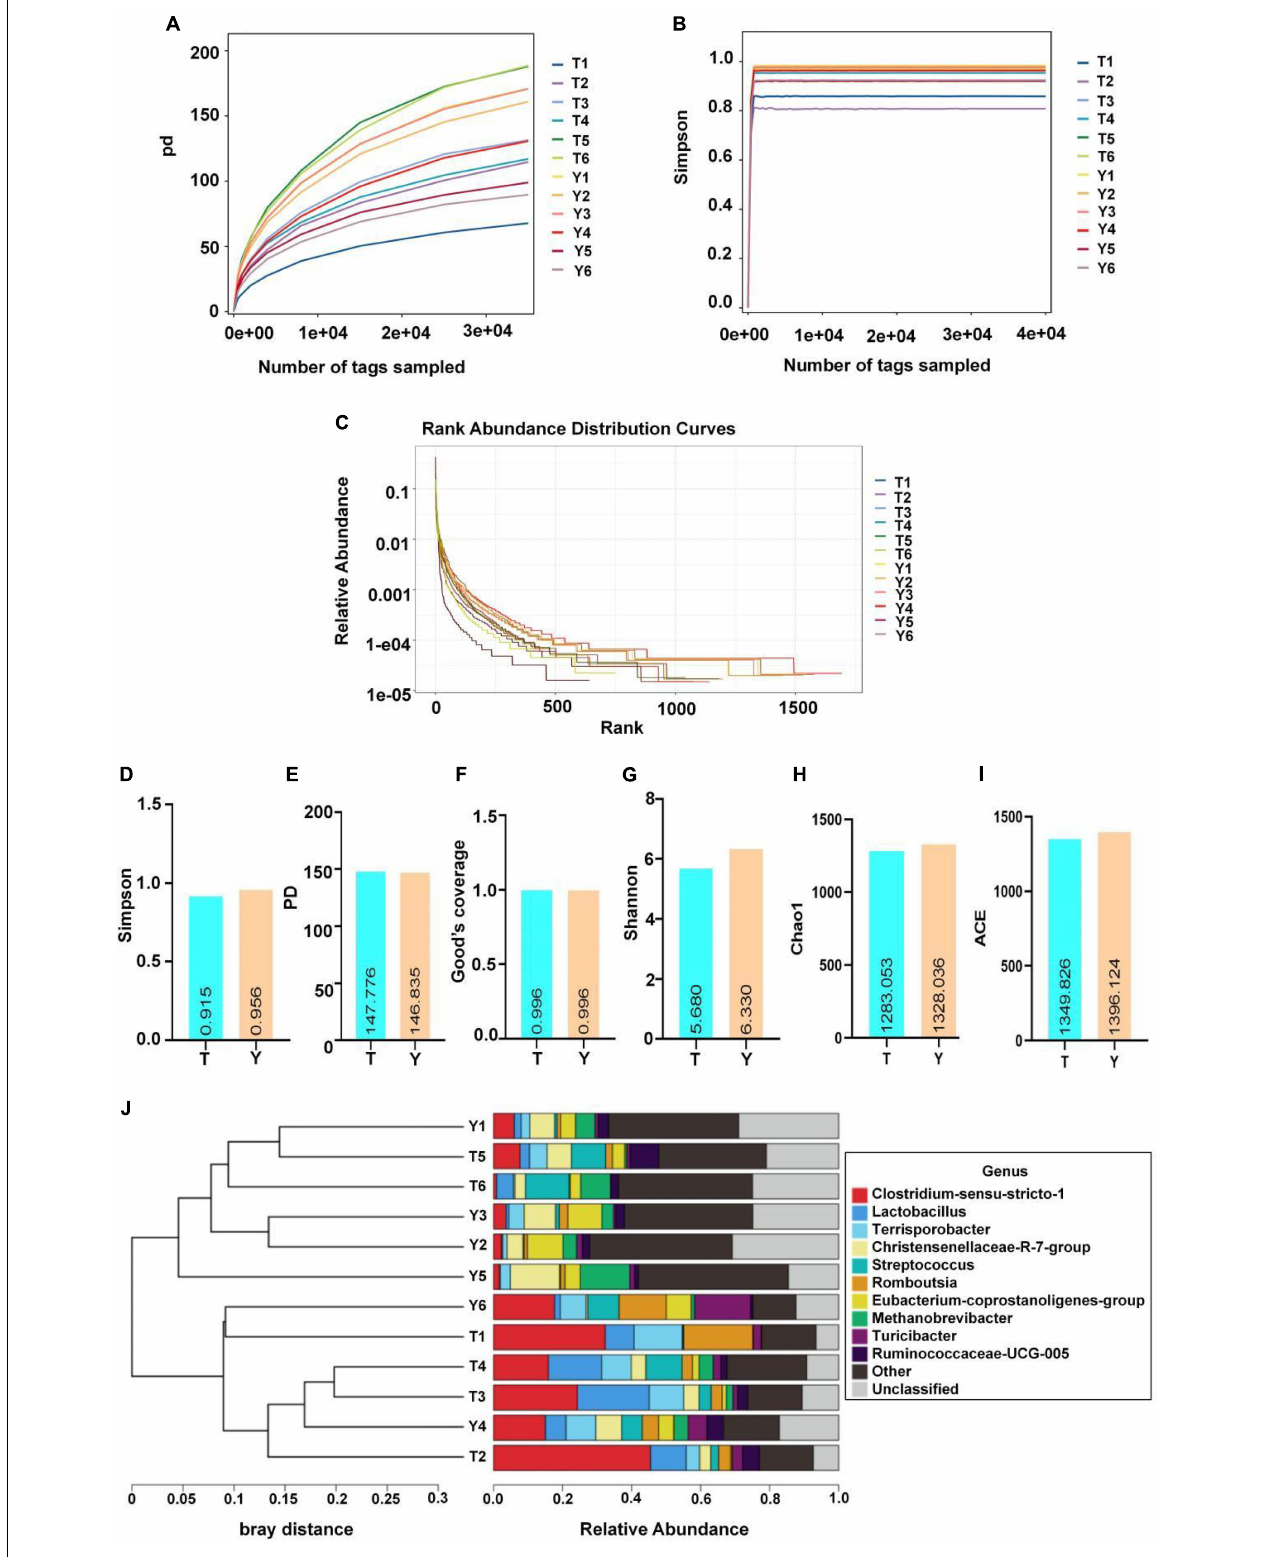
FIGURE 4 | Microbial diversity in colon of Tibetan (T) and Yorkshire (Y) pigs. (A) PD diversity index curve. (B) Simpson diversity index curve. (C) Rank abundance curve. (D–I) Alpha diversity index (Simpson, PD, Good’s coverage, Shannon, Chao1, and ACE). (J) UPGMA cluster tree. Each curve represents a sample.